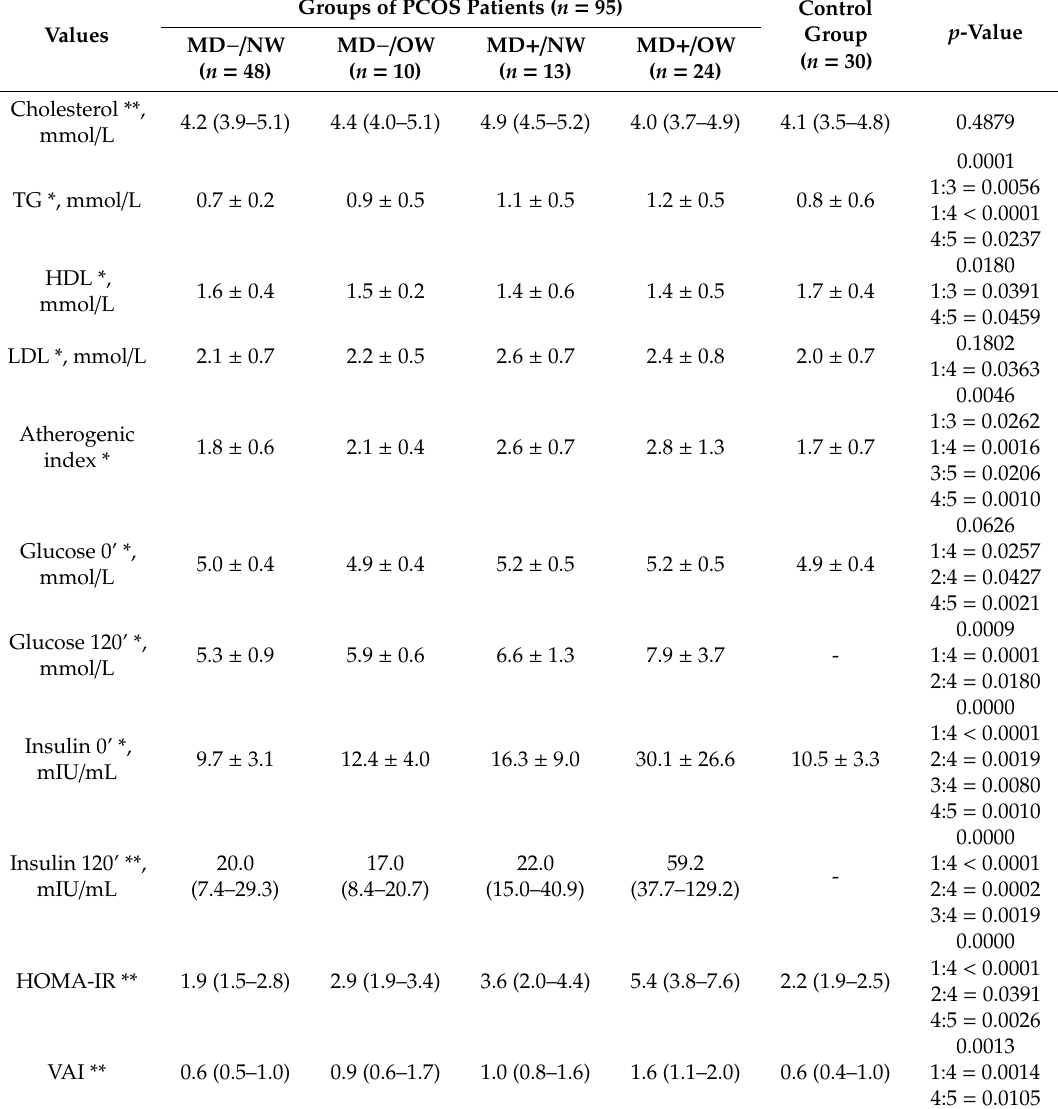
Table 1. Blood lipid profile values, results of the oral glucose tolerance test (OGTT) and visceral adiposity index (VAI) values in adolescents with polycystic ovary syndrome (PCOS), grouped by BMI and presence of